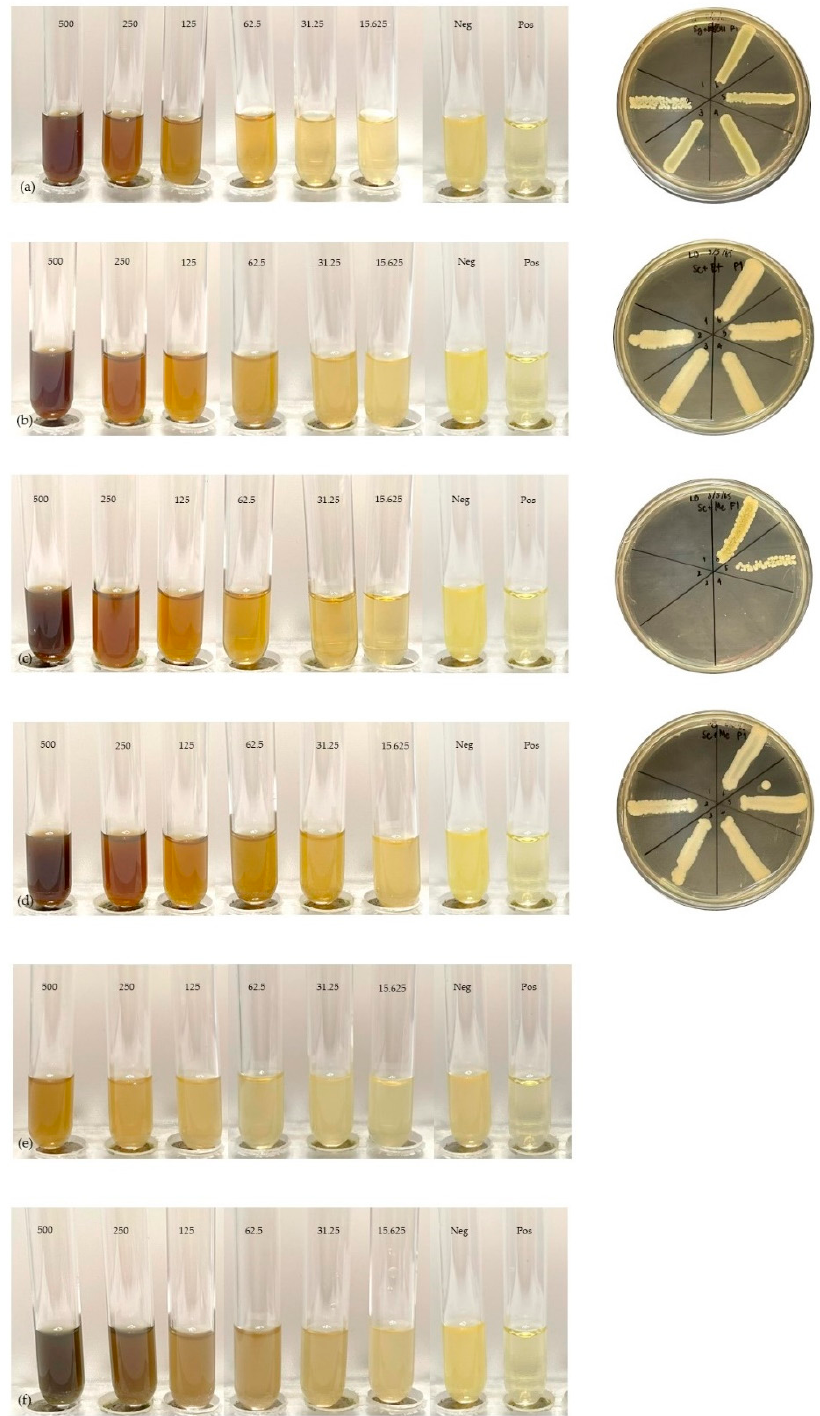
Figure 5. MIC and MBC with Smilax corbularia : ( a ) ethanol extract and bacteria M2. ( b ) Ethanol extract and bacteria M1. ( c ) Methanol extract and bacteria M2. ( d ) Methanol extract and bacteria M1. ( e ) Water extract and bacteria M2. ( f ) Water extract and bacteria M1.